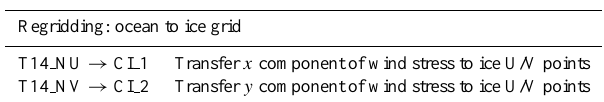
Table 1e. Details of regridding the ocean fields onto the ice U/V points in Fig. 4. These manipulations are in the NEMO subroutine CICE SBC IN